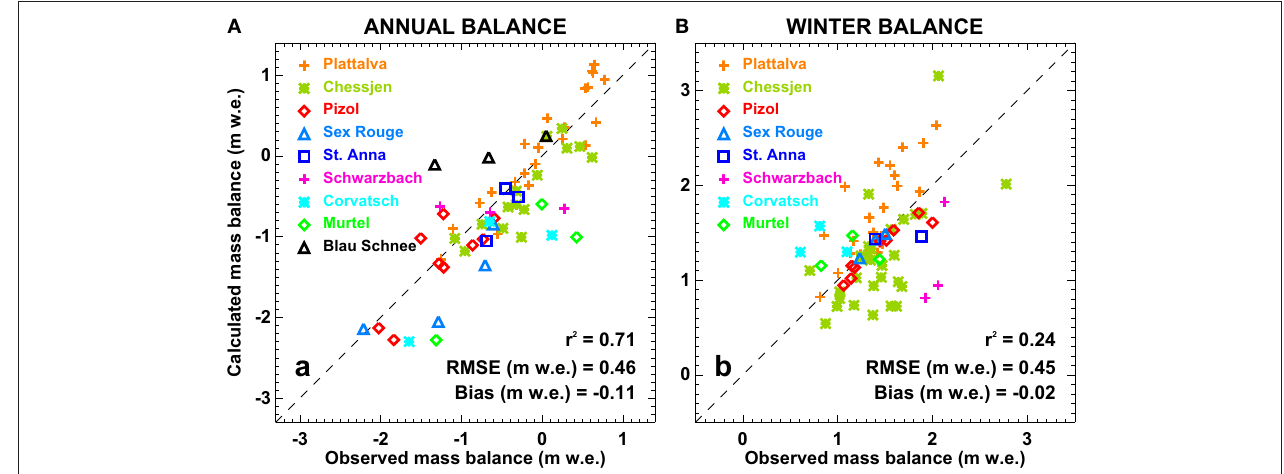
FIGURE 5 | Observed vs. calculated glacier-wide (A) annual and (B) winter mass balance. Values for individual glaciers are coded with different colors and symbols, and the linear correlation coefficient ( r 2 ), the root-mean-square error (RMSE), and the average error (bias) is given.